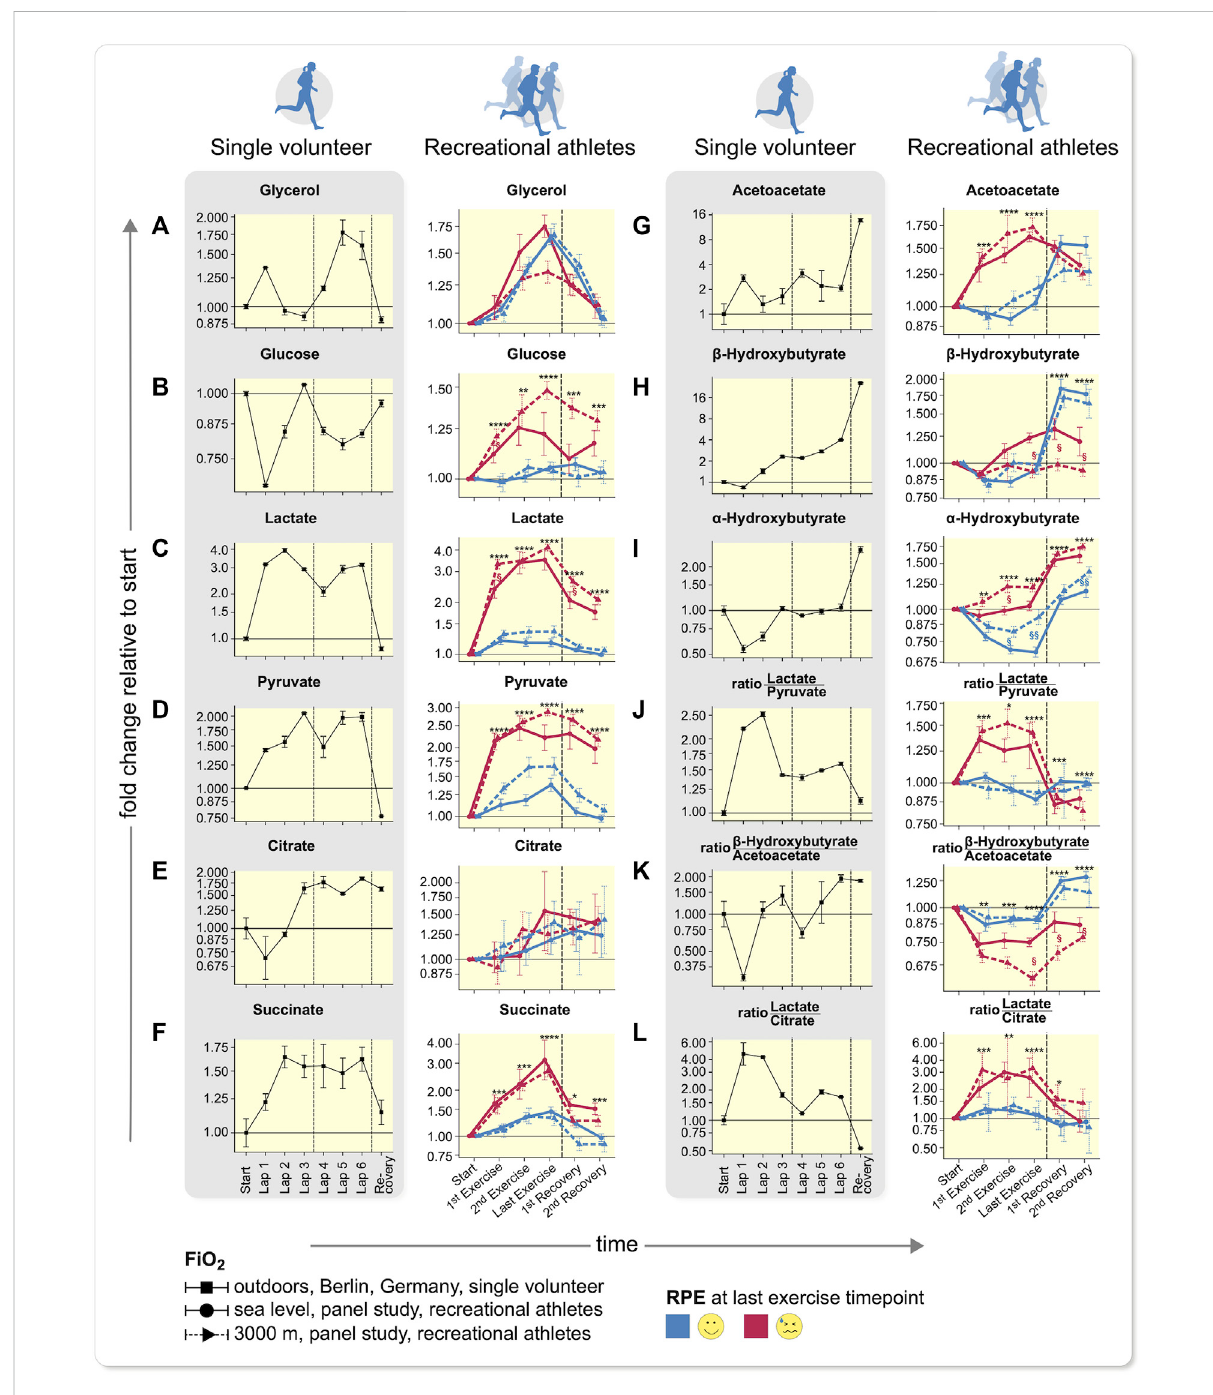
FIGURE 3 Time-pro fi les throughout exercise to recovery comparing single volunteer to recreational athletes. (A – F) Carbohydrate-based metabolite values, (G – I) ketone bodies, and (J – L) metabolite ratios in a single volunteer (left, error bars demonstrate deviations of duplicate measurments to anticipate the measurement accuracy) and recreational athletes (right) are shown (mean ± SEM). Difference between two technical replicate measurements are grouped according to Fi O 2 (solid: sea level, dotted: 3,000 m) and RPE at last exercise time-point. Dashed lines encompass comparabletimeintervalsindifferentsetups.Inpanelsontheleftonlyonerecoverytime-pointwasmeasured,whileintheRPErightpanelsexertion was not overcome; however, exercise was discontinued after 30 min. The samples between the vertical lines in the shaded, left plots depict a state, after overcoming subjective exhaustion that could not be compared to samples from the larger cohort study ( p -values from two sided WILCOXON - rank-sum ( BENJAMINI - HOCHBERG FDR-corrected), * p < 0.05; ** p < 0.01; *** p < 0.001; *** p < 0.0001 of all values within one RPE-group, for clarity only signi fi cance vs. lowest RPE group is shown, but all comparisons were accounted for p -value correction, § p < 0.05; §§ p < 0.01 between hypoxia and normoxia of lowest RPE group. Explanations see main text. Low RPE: n = 29, high RPE: n =